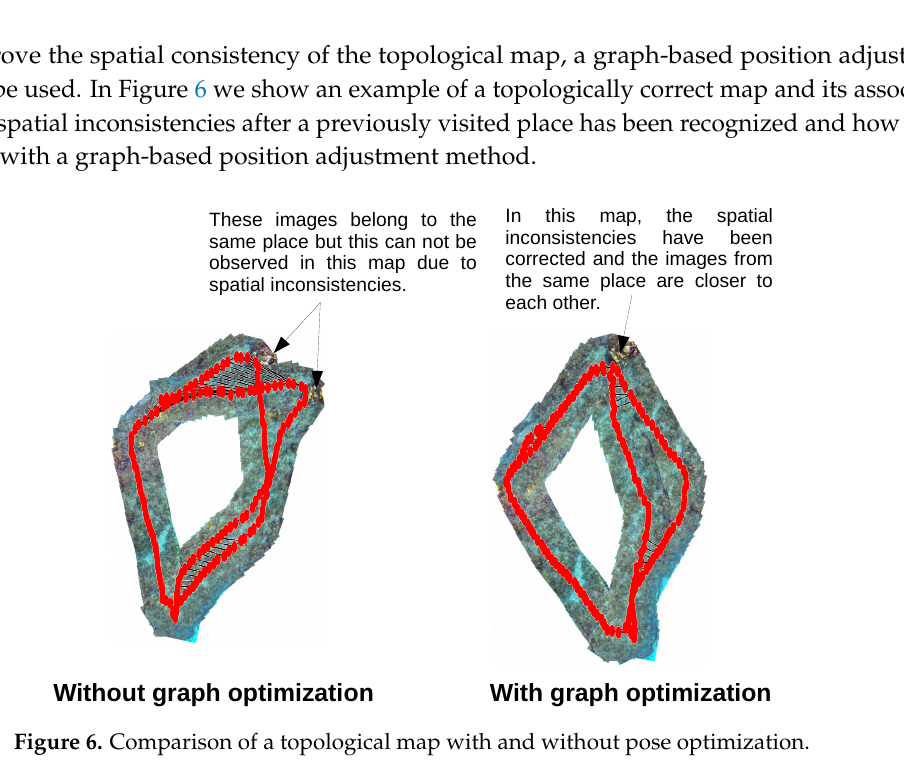
Figure 6. Comparison of a topological map with and without pose